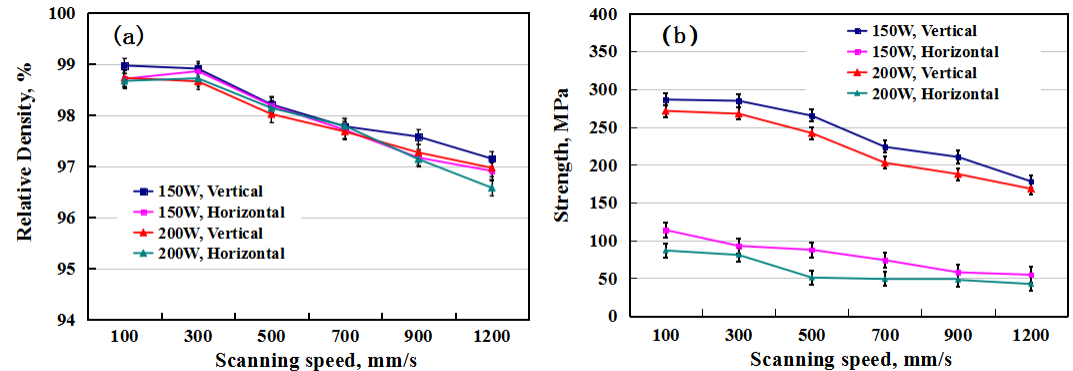
Figure 6. ( a ) The relative density and ( b ) strength changes with scanning speed for the vertical and horizontal samples, respectively.